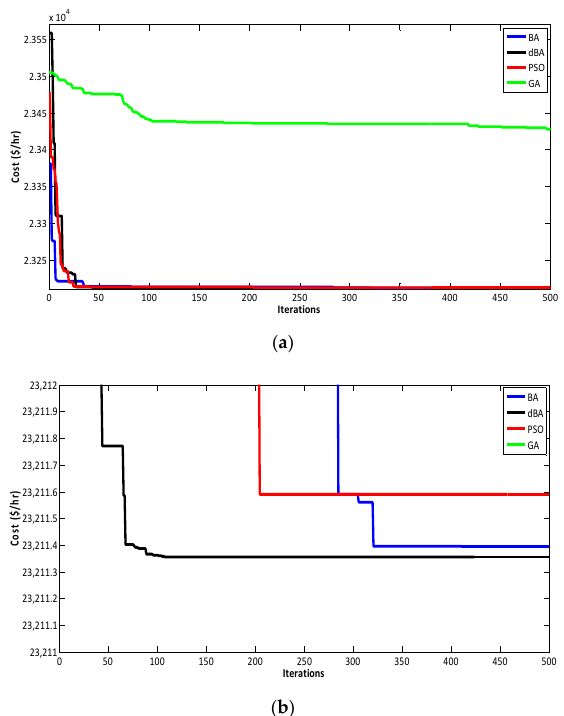
Energies 2020 , 13, x; FOR PEER REVIEW Figure 10. Convergence curve: ( a ) Convergence graphs without renewables; ( b ) Magnified view.